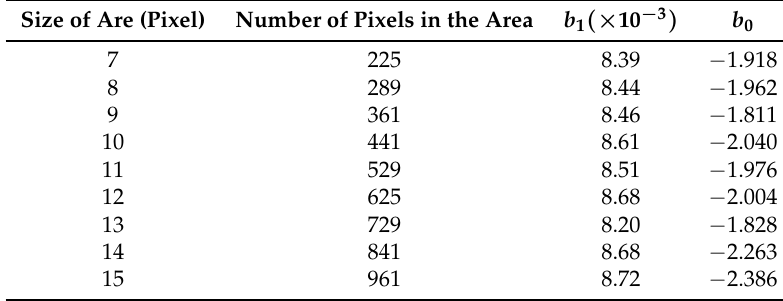
Table 1. The values of b 1 of LF for different values of r , for the selected pixel of the dish. Size of Are (Pixel) Number of Pixels in the Area b 1 ( × 10 − 3